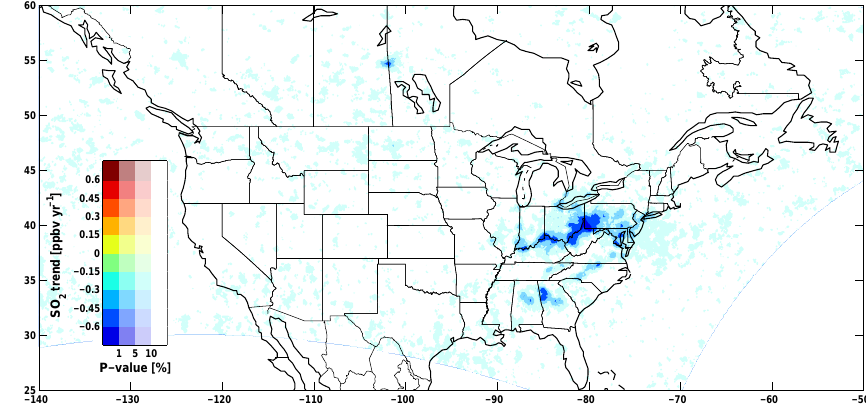
Figure 3. Spatial distribution of the OMI-derived surface SO 2 trend at 0 . 1 ◦ × 0 . 1 ◦ over North America for the years of 2005–2015. Statistical significance is shown in the form of a two-sided p value, tested against null being the zero